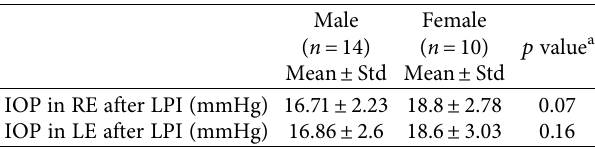
Table 4: Comparison between gender and IOP reduction after LPI.